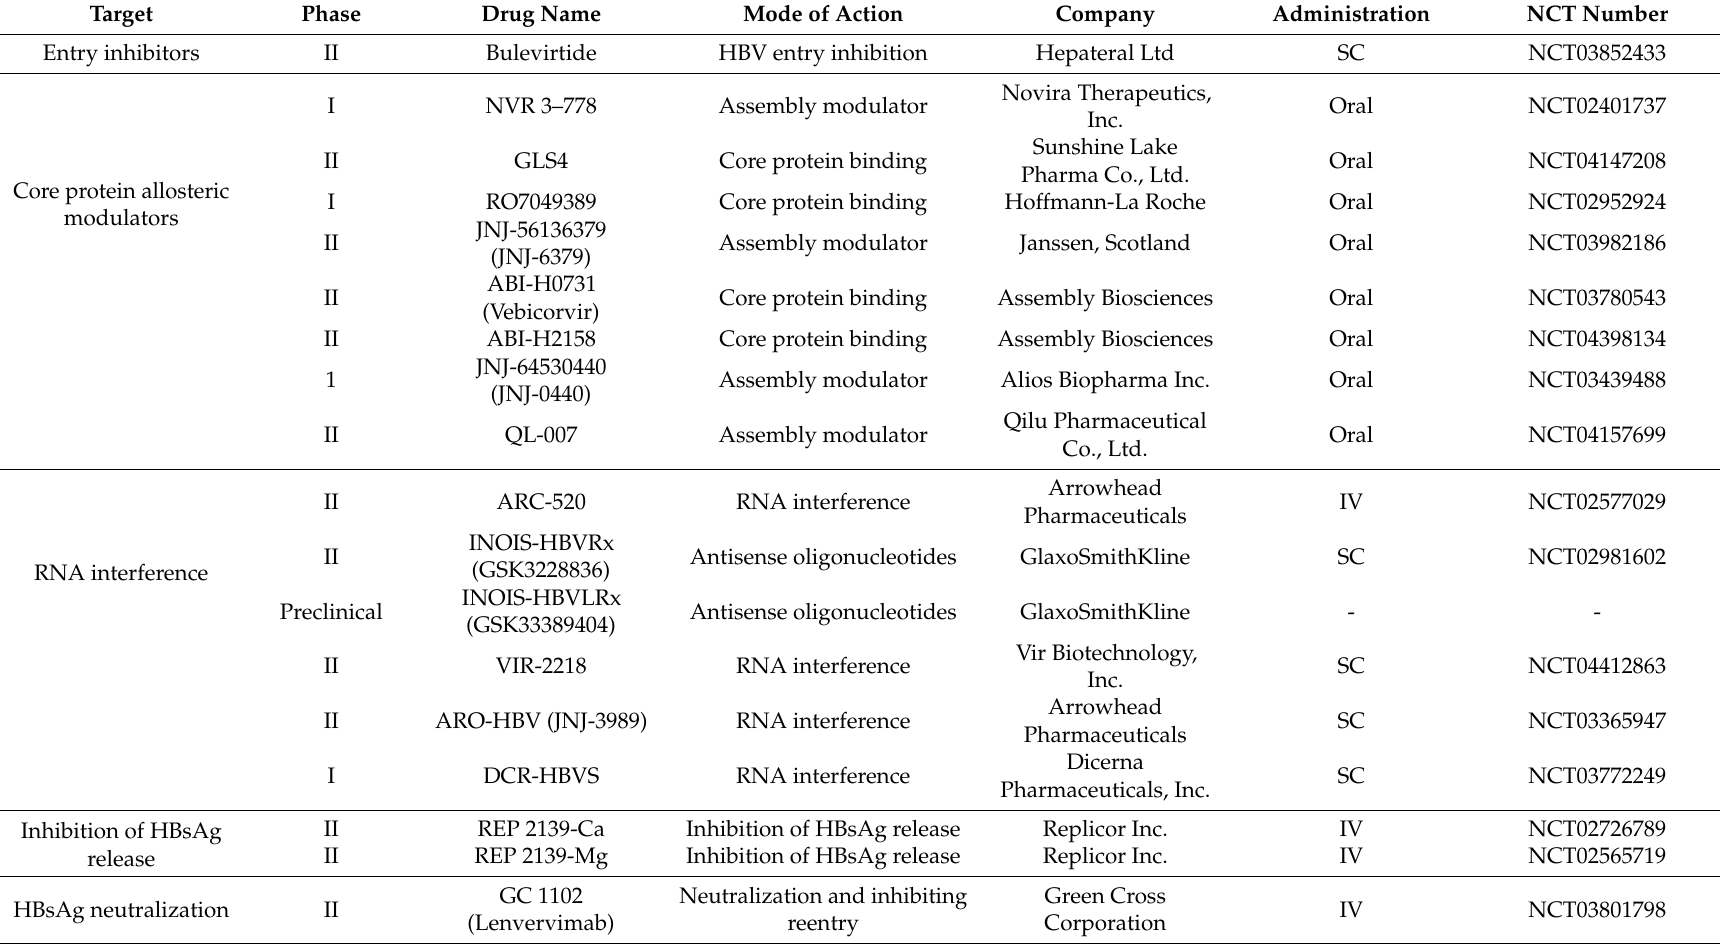
Table 1. Summary of new antiviral drugs for hepatitis B